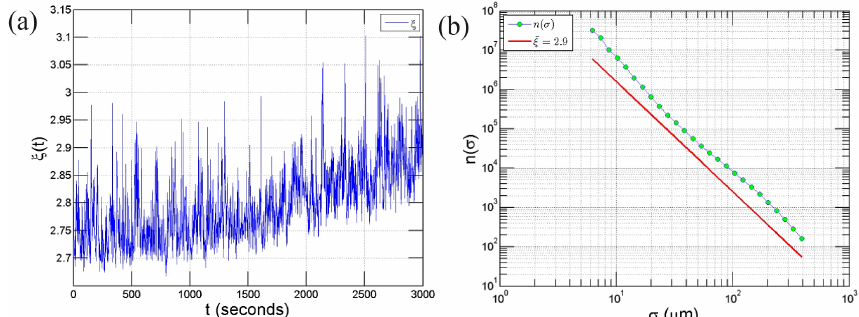
Figure 3. The first 3000 samples of the time series of PSD slope ( ξ ) (a) and PSD slope of the entire data set with a power-law fit with a slope value of ξ = 2.9 ± 0.16 (b) .